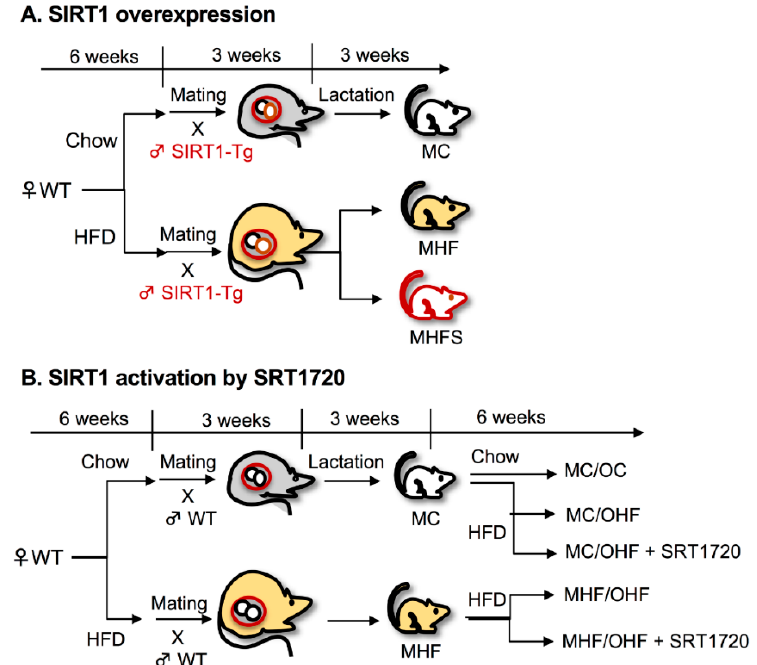
Figure 1. Animal models of SIRT1 overexpression ( A ) and activation ( B ) in offspring. SIRT: sirtuin; MC: offspring of chow-fed dams; MHF: offspring of HFD-fed dams; MHFS: MHF offspring with SIRT1 overexpression. OC: chow-fed offspring; OHF: HFD-fed offspring; WT: wild-type; Tg: transgenic, HFD: high-fat diet.